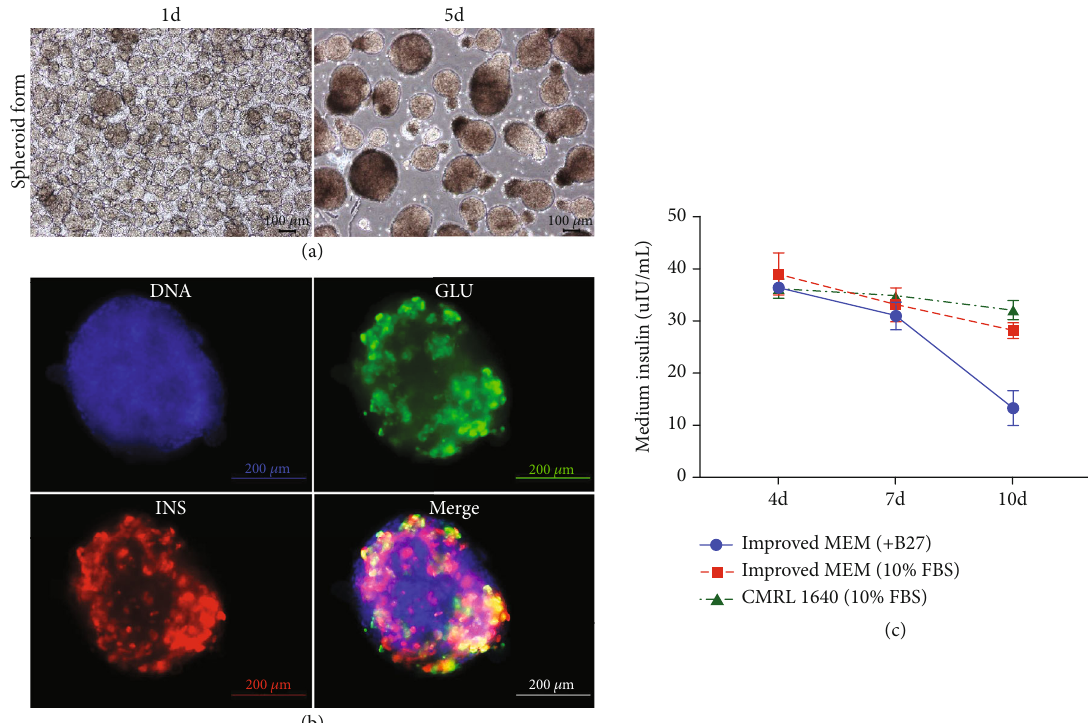
Figure 6: Spheroid formation and sustained maintenance of IPCs. (a) Many small clusters of IPCs form after day 1 of IPC dissociation, and numerous spheroid IPCs are generated after 5 d. (b) Many cells express insulin or glucagon in spheroid IPCs. (c) Levels of insulin are decreased in di ff erentiated IPCs cultured with improved MEM (1 × B27) that was used for di ff erentiation after continuous culture for 10 d. Cells stably secrete insulin in culture medium containing 10%